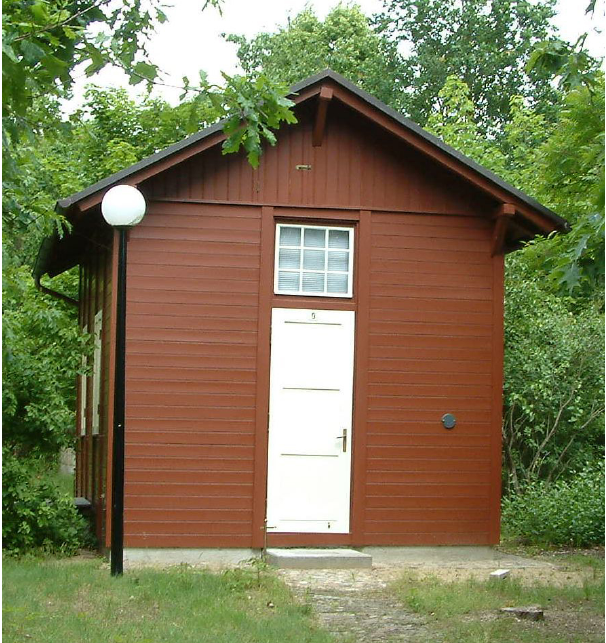
Figure 5. Absolute hut of Seddin Observatory after its relocation to the present location in Niemegk and renovation in 2005. Source: Helmholtz Centre Potsdam –